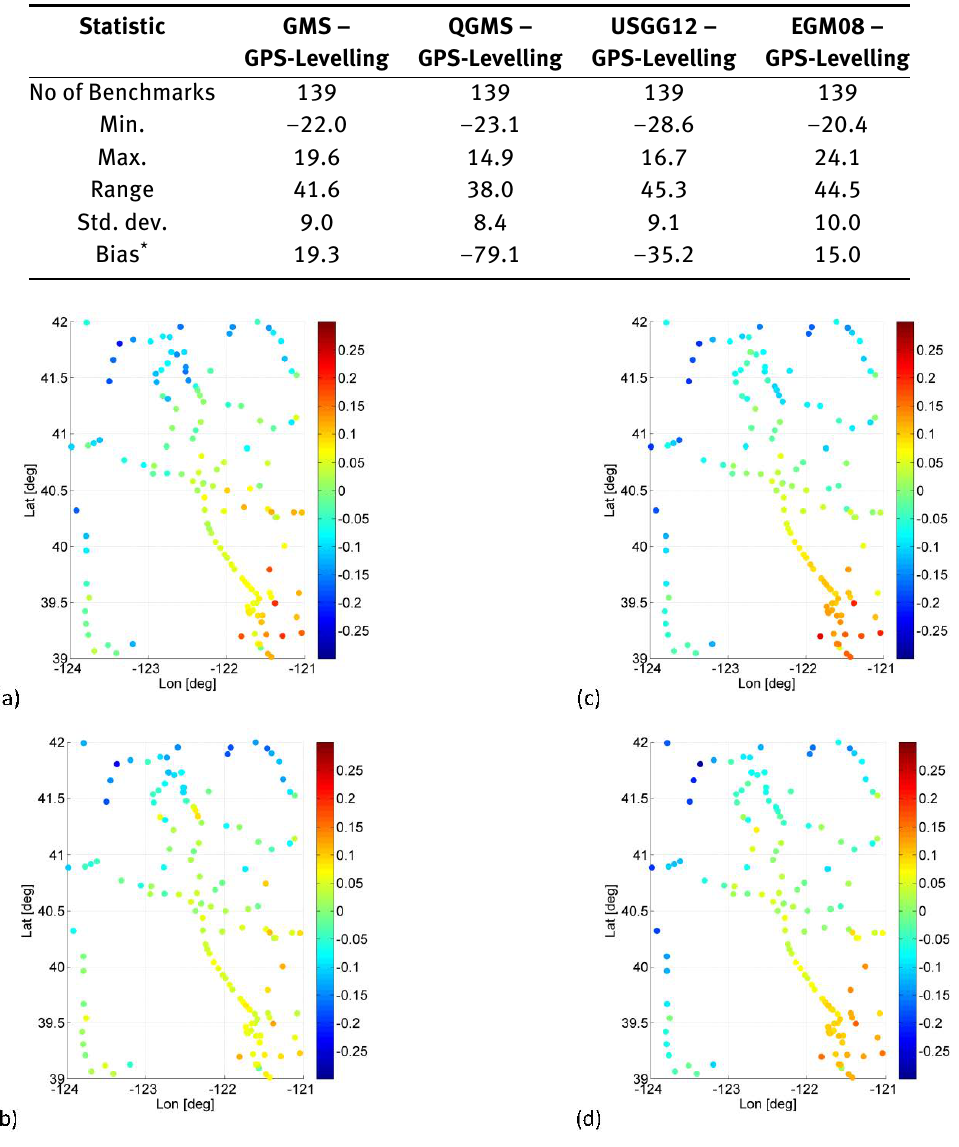
Table 6: Statistics of the differences between the different geoids and GPS-levelling benchmarks for the California test area. Unit is in cm